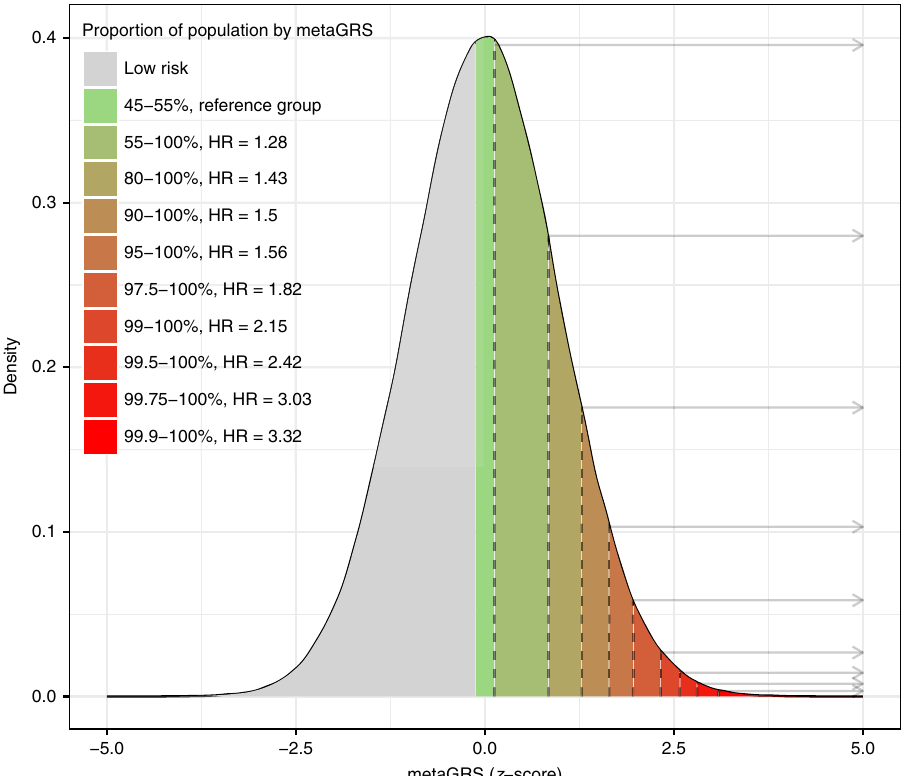
Fig. 3 The metaGRS identi fi es individuals at increased risk of ischaemic stroke. Shown is the distribution of the metaGRS for ischaemic stroke in the UK Biobank validation set ( n = 395,393), and corresponding hazard ratios. Hazard ratios are for the top metaGRS bins (strati fi ed by percentiles) vs. the middle metaGRS bin (45 –